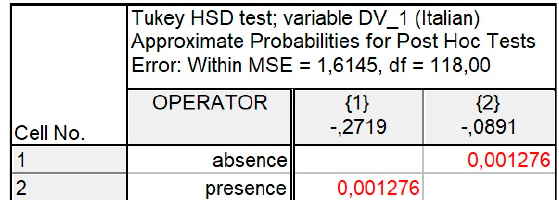
Figure 18. Operator mean results (Italian).